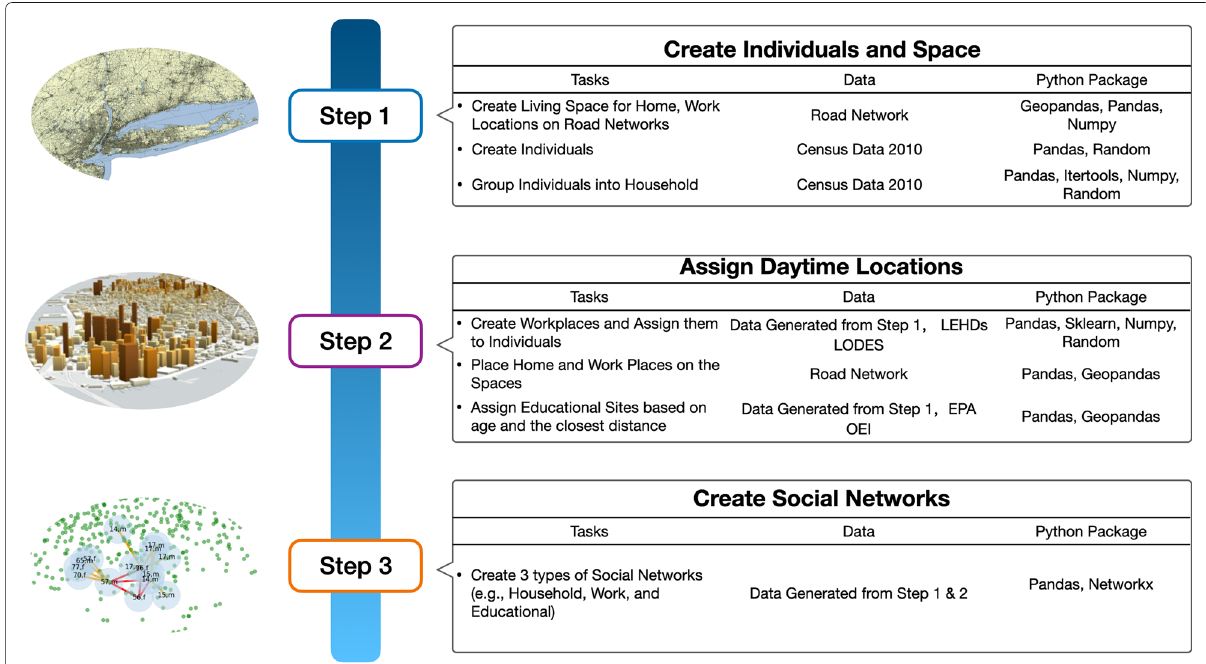
Fig. 2 Workflow for Generation of Synthetic Population and Networks